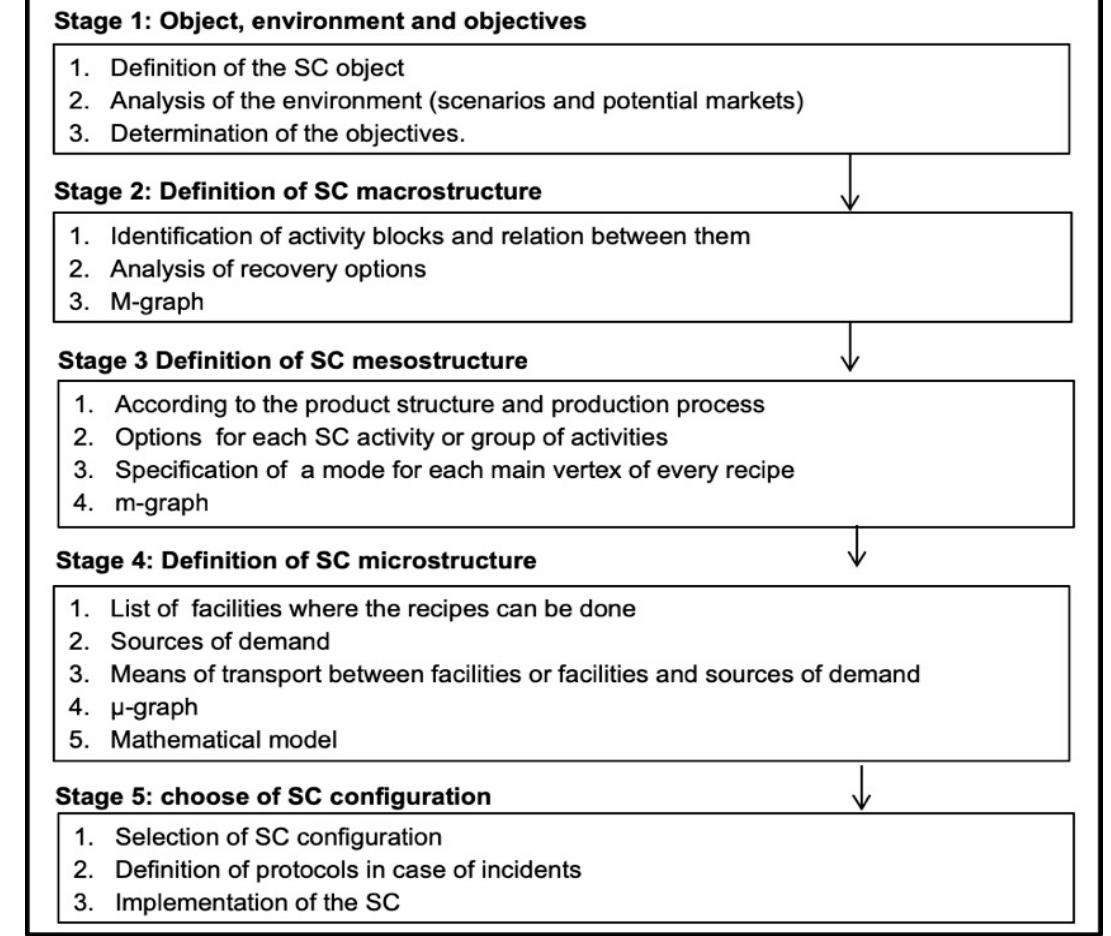
Figure 1. General layout of Supply Chain Outline Process (SCOP) (Adapted from [16]).